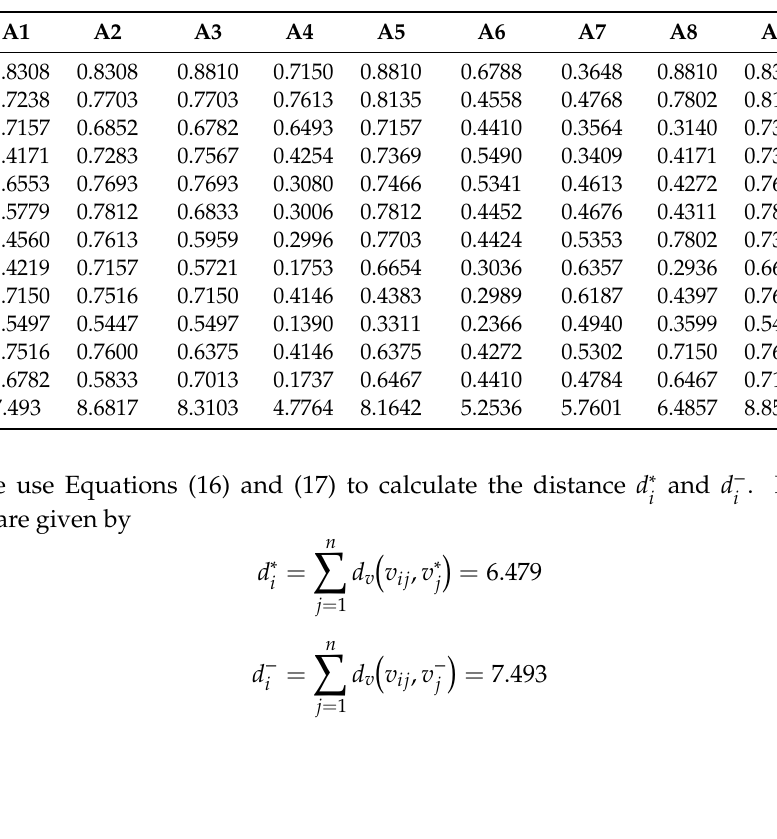
Table 15. Distance d v ( A i , A − ) for